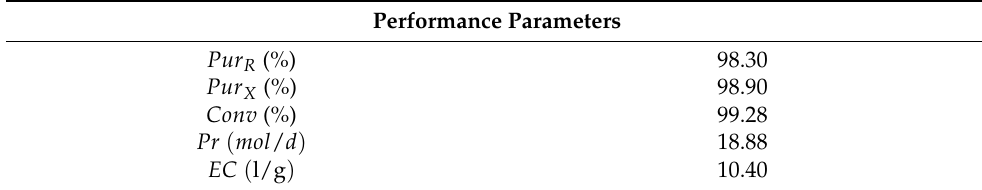
Table 7. TMBR Performance